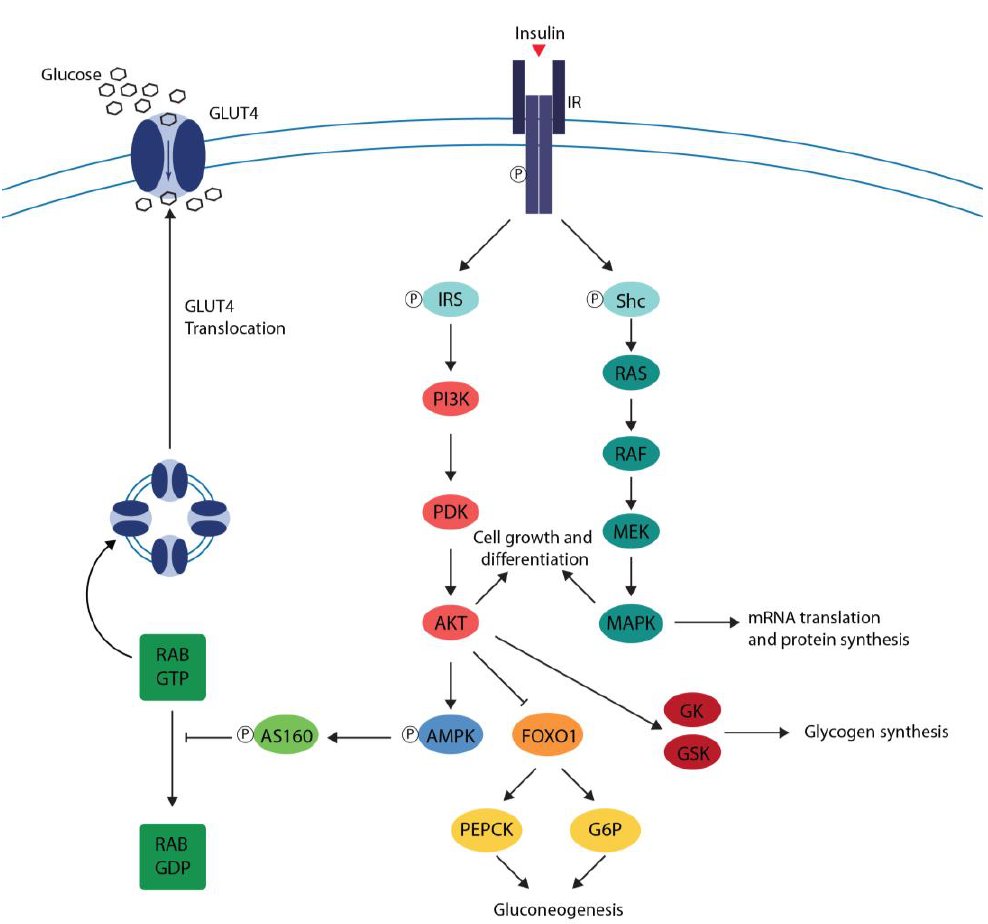
Figure 1. Normal insulin signaling. Insulin binds to the insulin receptor (IR) inducing a conformational change and a rapid autophosphorylation of IR leading to the recruitment and phosphorylation of receptor substrates such as insulin receptor substrate (IRS) and Shc proteins. Shc proteins activate the Ras / mitogen-activated protein kinase (MAPK), whereas IRS proteins mostly activates the phosphoinositide 3-kinase (PI3K) / Akt pathway by recruiting and activating PI3K. In the skeletal muscle and adipose tissue, the PI3K / Akt pathway induces AMP-activated protein kinase (AMPK) phosphorylation and the expression of the glucose transporter type 4 (GLUT4) and its translocation from intracellular vesicles to the cell membrane promoting the uptake of glucose. In the liver, the PI3K / Akt pathway inhibits the expression of phosphoenol pyruvate carboxykinase (PEPCK), and glucose-6-phosphatase (G6P) suppresses gluconeogenesis and activates glucokinase (GK) and glycogen synthase kinase (GSK), promoting glycogen synthesis. Arrow stimulates, T bar inhibits